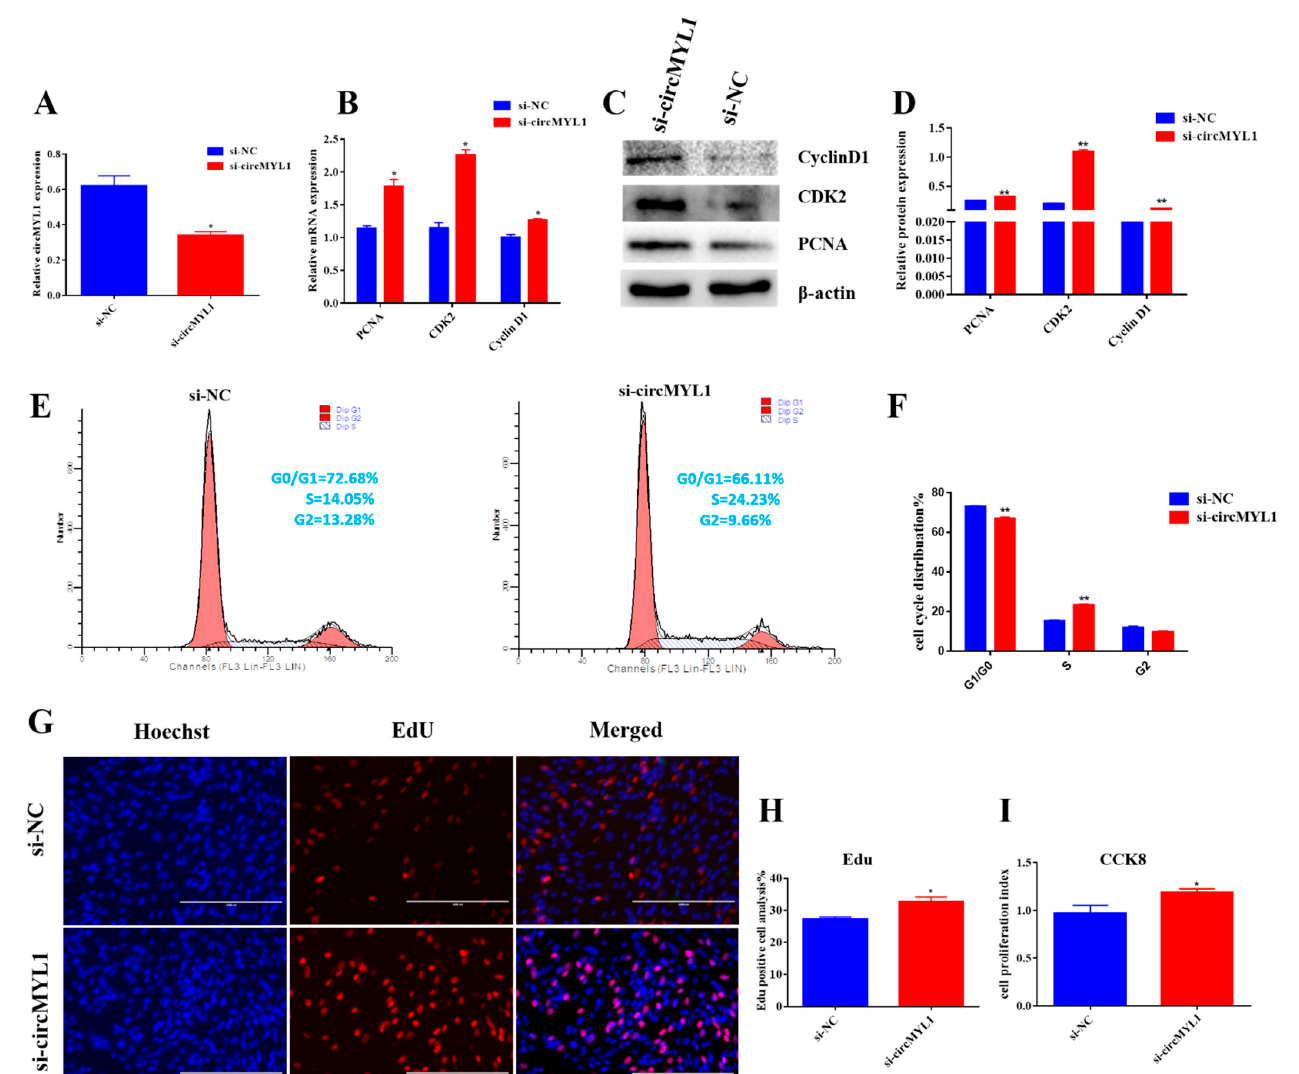
Figure 3. Knockdown of circMYL1 promotes the proliferation of bovine primary myoblasts ( A ) qRT-PCR detected the interference effect of siRNA (si-circMYL1). ( B ) qRT-PCR detected the relative expression levels of proliferation marker genes PCNA , CDK2 , and CyclinD1 . ( C ) Western blot detected the protein expression levels of proliferation marker genes PCNA , CDK2 , and CyclinD1 . ( D ) Histogram graph showing the protein band density evaluated using ImageJ. ( E ) Bovine primary myoblasts were transfected with si-circMYL1, and the cell cycle was analyzed by flow cytometry. ( F ) Histogram graph showing the number of cells in each phase of the cell cycle. ( G ) The cell proliferation was detected by (EdU) assay after transfection of si-circMYL1. EdU staining (red) for positive cells. DAPI staining (blue) for the cell nuclei. Scale bar, 200 μ m. ( H ) Graph of a histogram showing the percentage of EdU-positive cells, and counted using ImageJ. ( I ) The cell counting kit-8 (CCK-8) assay was used to detect the cell proliferation index. Data are shown as mean ± SEM. n = 3. * p < 0.05; ** p < 0.01.